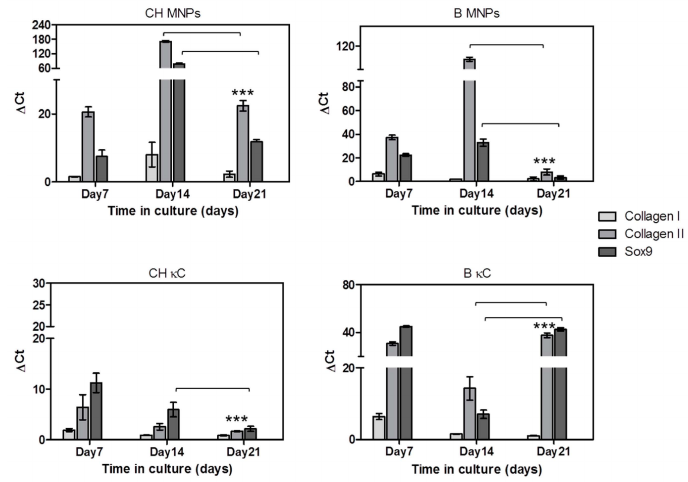
Figure 5. Relative expression of chondrogenic-specific transcripts, namely Collagen type I , Collagen type II and Sox9 of hASCs cultured on MNPs- κ C-hydrogels for 7, 14 and 21 days under the actuation of an external magnetic field. The expression of these genes was normalized against the housekeeping gene GAPDH and calculated by the ∆ CT method. Data was analyzed by two-way ANOVA, followed by Bonferroni post-tests. Horizontal bracket lines denote statistically significant differences ( p < 0.05) when comparing Day 14 with Day 21 time points and *** corresponds to a significant statistical difference ( p < 0.001) for Day 21 in different conditions. MNPs- and MNPs-free- κ C-hydrogels (experimental controls) cultured in chondrogenic medium are designated as CH MNPs and CH κ C, respectively, while MNPs and MNPs-free- κ C-hydrogels cultured in basal medium are labeled as B MNPs and B κ C,